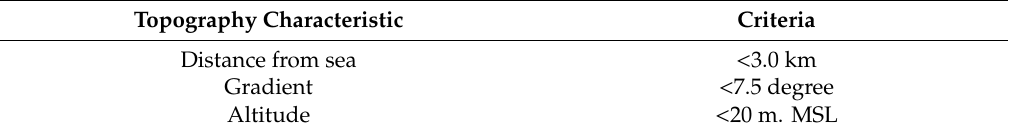
Table 2. Criteria of the 3 characteristics of topography used to identify the coastal zone.